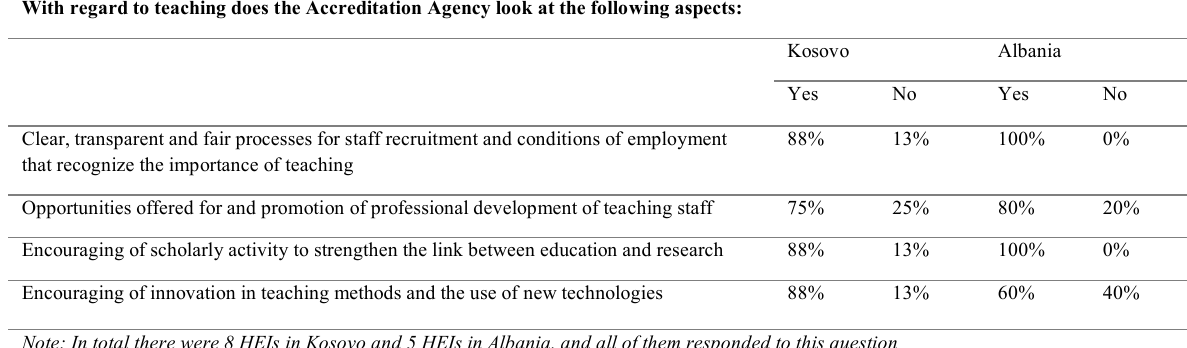
Table 6: Internal quality assurance: Teaching staff in the HEIs of Kosovo and